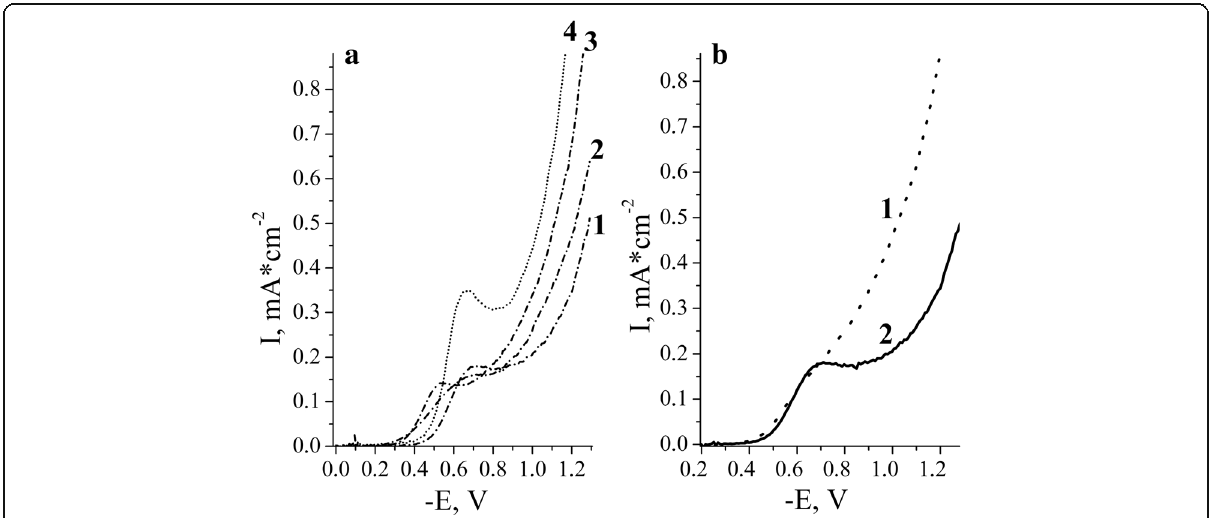
Fig. 5 a Current-voltage curves for oxygen reduction in solution of 0.9% NaCl at the electrodes: ( 1 ) — TiO 2 , ( 2 ) — TiO 2 /Ni 2+ , ( 3 ) — TiO 2 /Co 2+ , ( 4 ) — TiO 2 /Cu 2+ (1% of dopant). b Current-voltage curves for oxygen reduction in solution of 0.9% NaCl at the TiO 2 /Mn 3+ electrode: ( 1 ) — first cycle, ( 2 ) — after cycling; v = 10 mV s −